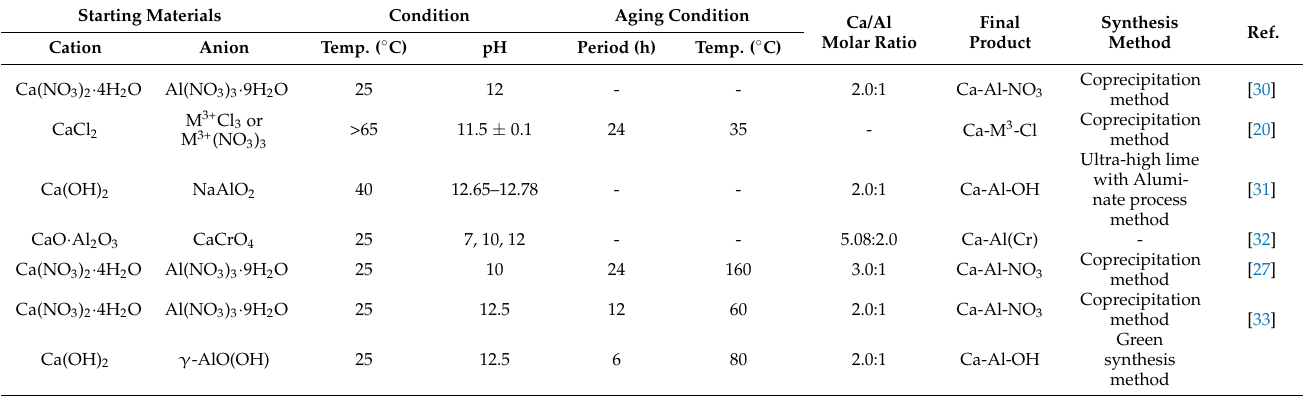
Table 1. Summary of synthesis methods for CaAl-LDH phases in previous studies [20,27,30–33]. Starting